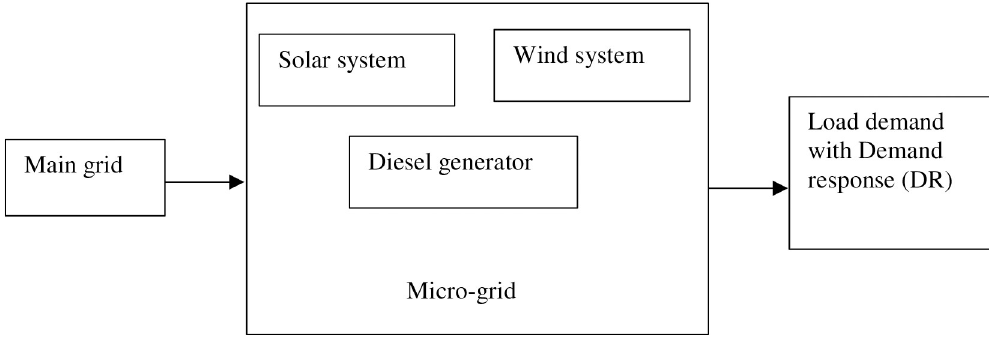
Fig 1. Grid-connected microgrid with demand response